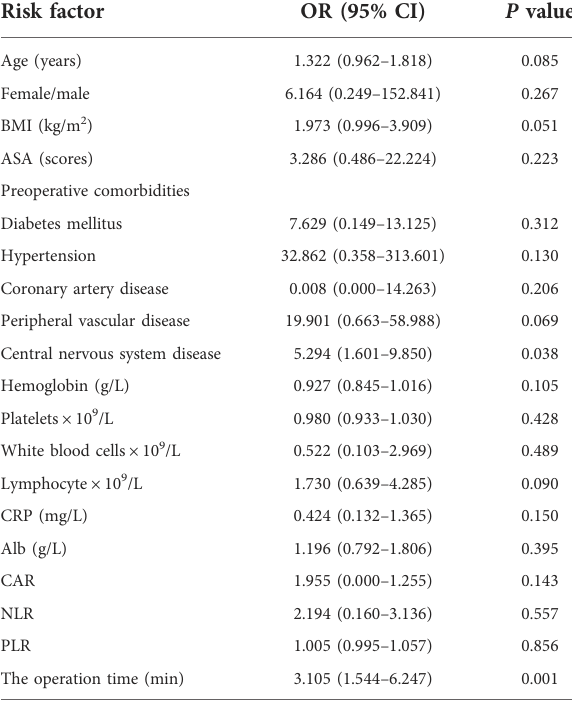
TABLE 5 Logistic regression analysis for POD patients